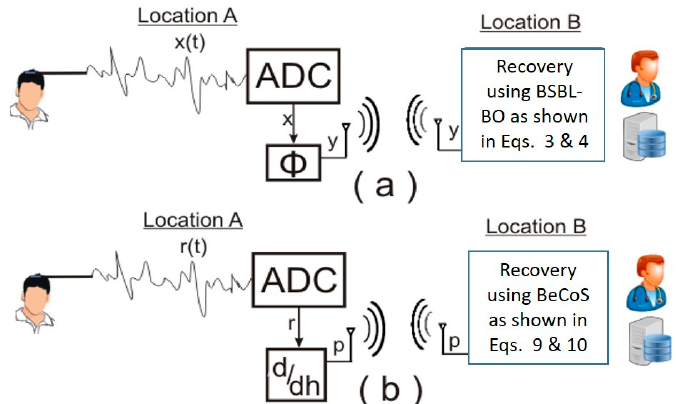
Figure 4. System diagram for testing models: ( a ) block sparse Bayesian learning-bound optimization (BSBL-BO) and ( b ) BeCoS.